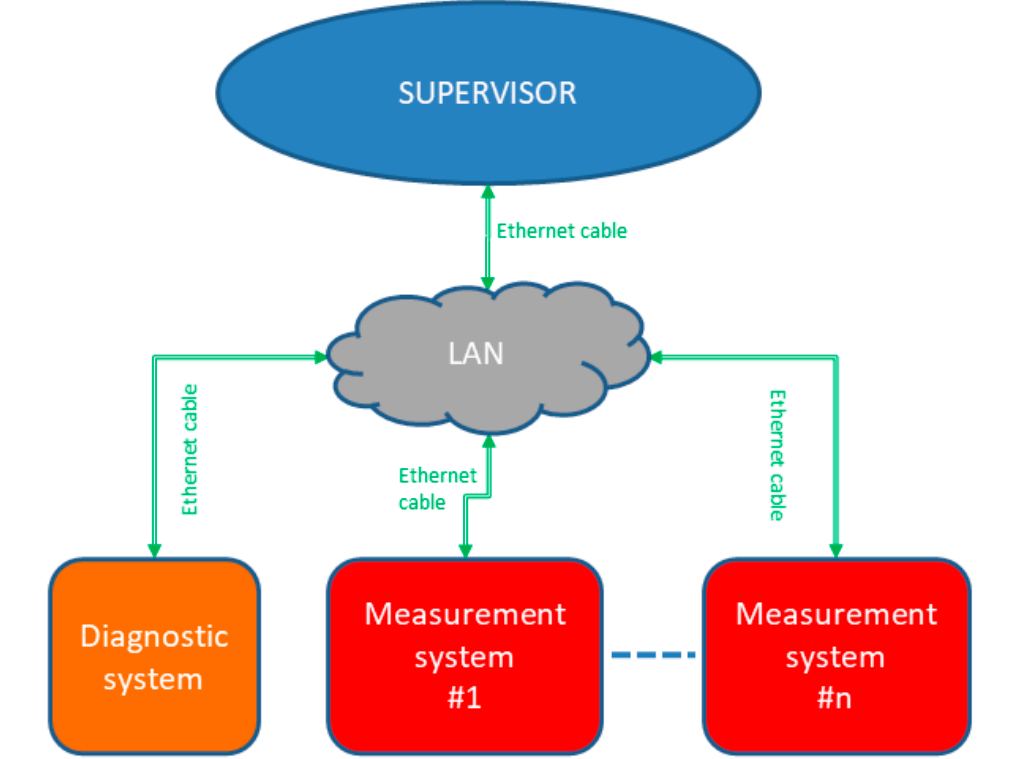
Figure 2. Simplified block diagram of the proposed system.